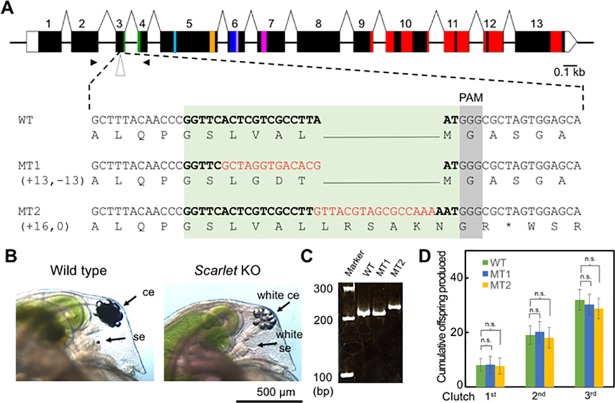
Knockout of the DapmaSt in D. magna.(A) Schematic gene structure of DapmaSt and the partial sequences of a wild-type (WT) and two DapmaSt mutants (MT1 and MT2). The green, light blue, yellow, dark blue, purple, and pink boxes indicate the Walker A/P-loop, Q-loop, ABC signature motif, Walker B, D-loop, and Switch/H-loop. Red boxes show transmembrane regions. The target sites for gRNA are indicated by bold letters and insertions are indicated by red letters. The protospacer adjacent motif (PAM) sequence is colored in grey. (B) The phenotype of DapmaSt mutant with the cephalic regions of a wild type and the DapmaSt mutant (MT2) are magnified. The ce and se refer to the compound eye and single eye (ocellus). (C) Polymerase chain reaction for genotyping of WT, MT1, and MT2. The amplified genomic DNA fragments were resolved by agarose gel electrophoresis. (D) Comparison of fecundity between WT, MT1, and MT2. The cumulative number of offspring was counted at each clutch. Error bars indicate the standard error of the mean (n = 3). n.s. indicates P > 0.05 (Student’s t-test).